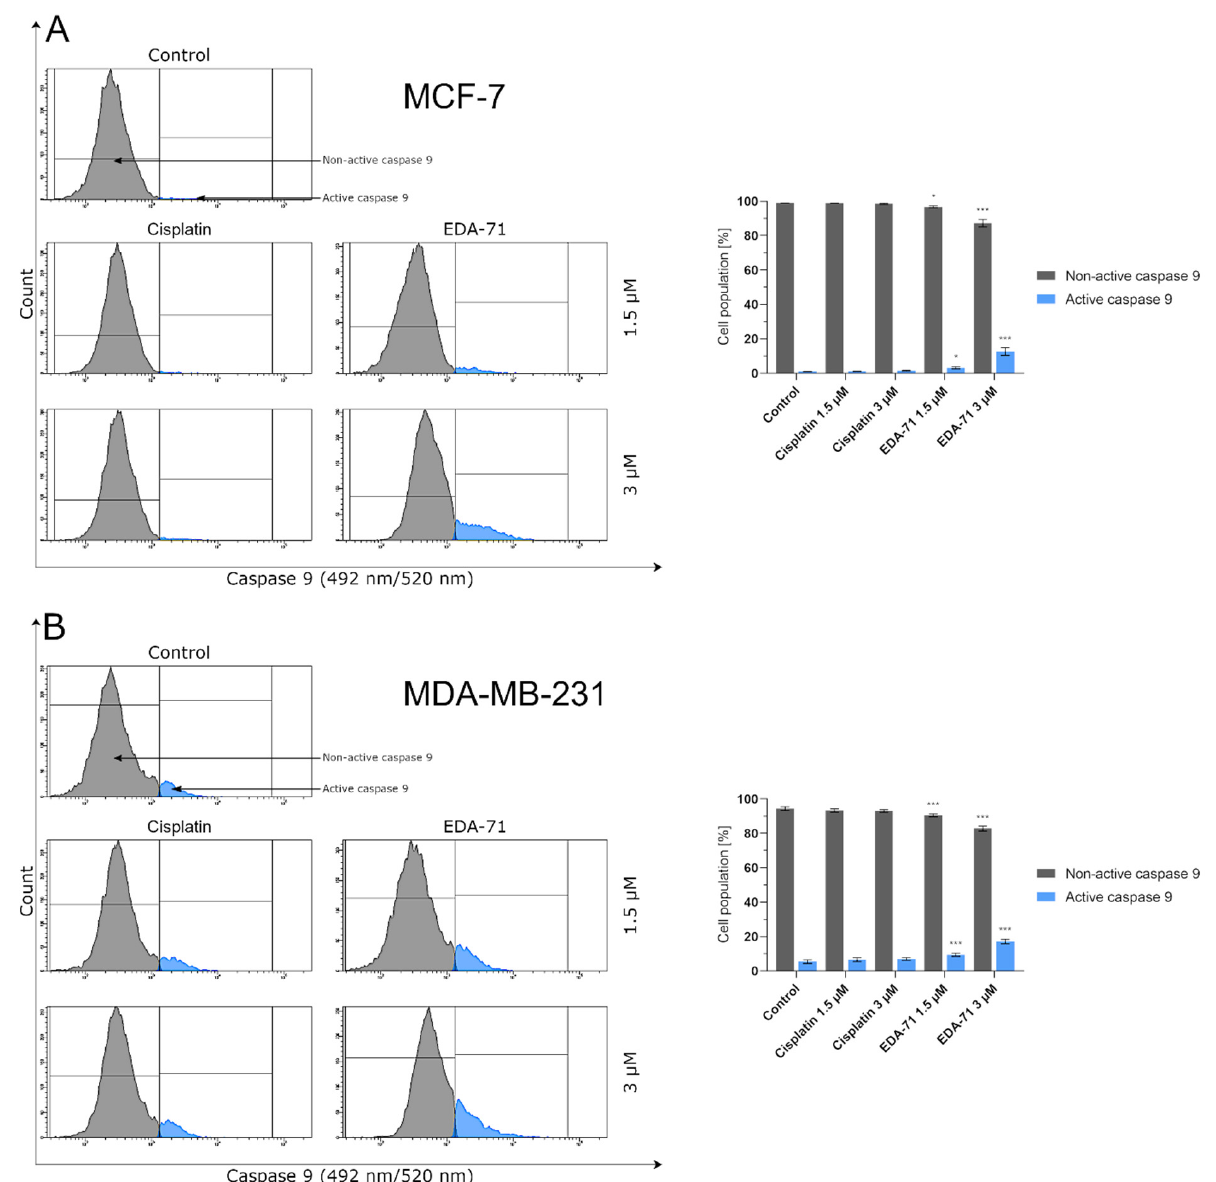
Figure 9. Cytometric analysis of caspase 9 activity in MCF-7 ( A ) and MDA-MB-231 ( B ) breast cancer cells after 24 h incubation with EDA-71 and cisplatin (1.5 and 3 µM). Results are presented as mean values ± SD obtained from three independent experiments ( n = 3) conducted in triplicate. Statistical differences between the experimental (treated cells) and control (untreated cells) groups were determined using one-way ANOVA followed by Dunnett’s test. * p < 0.05 vs. control group, *** p < 0.001 vs. control